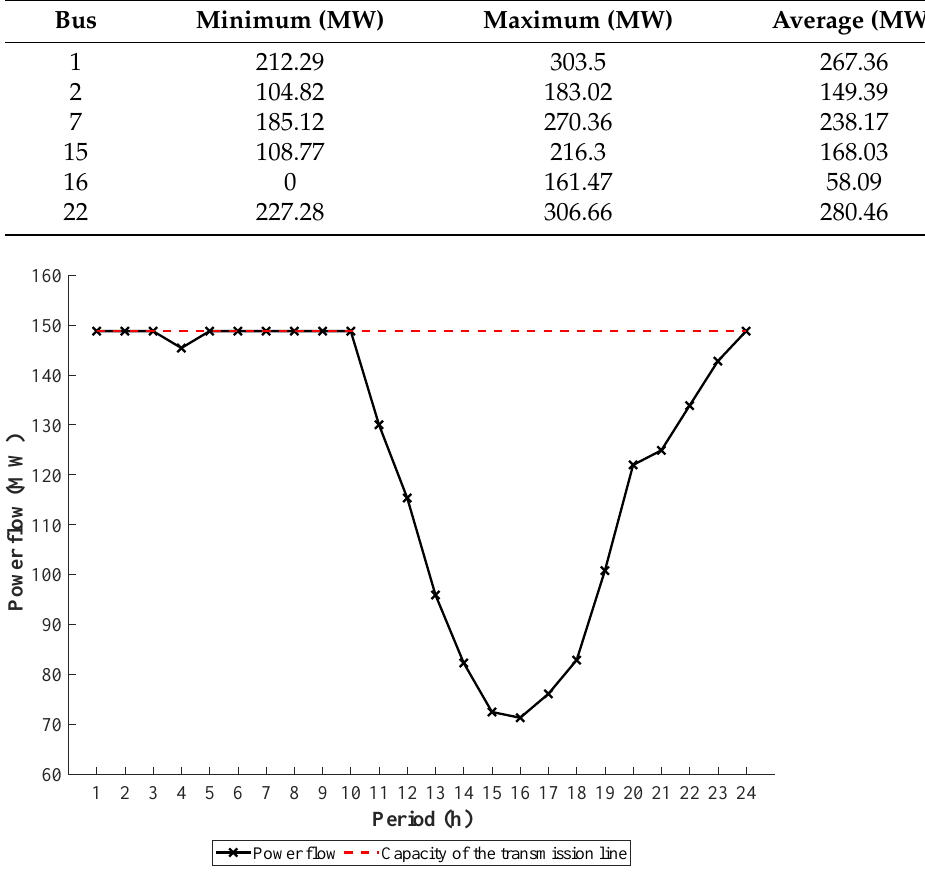
Figure 7. Wind power generation and wind power curtailment (WPC) of bus 7 in Case 1. Table 4. Summary of wind and photovoltaic power generation values. Data source: [27].